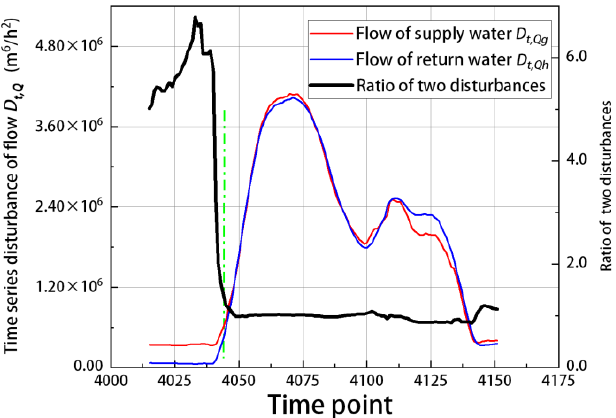
Figure 8. Time-series disturbance value and time-series disturbance ratio of the flow data.